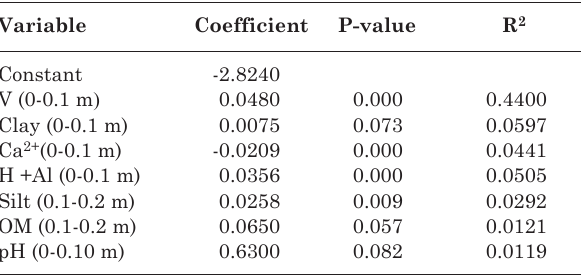
table 3. Results of stepwise regression of corn grain yield and soil properties in the 0–0.1